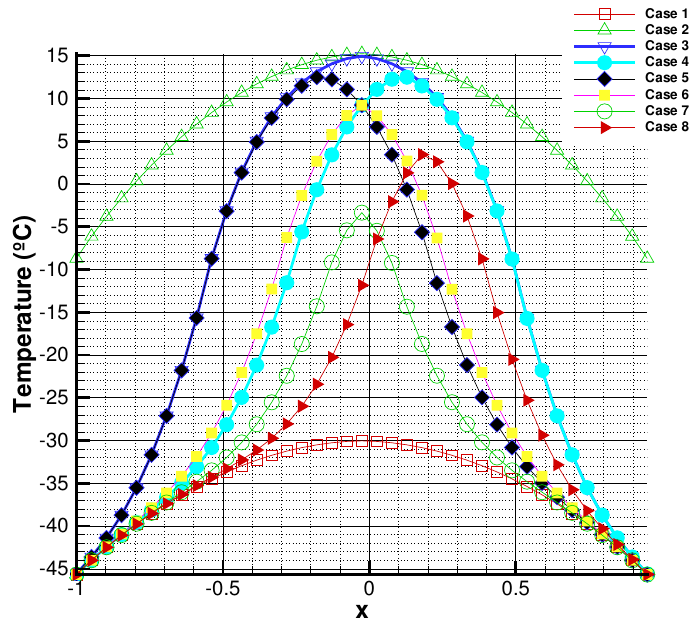
Figure 3. Several stationary solutions of the EBM model, without coupling with the deep ocean, for Q = 250. This is the region of multiple stationary solutions.